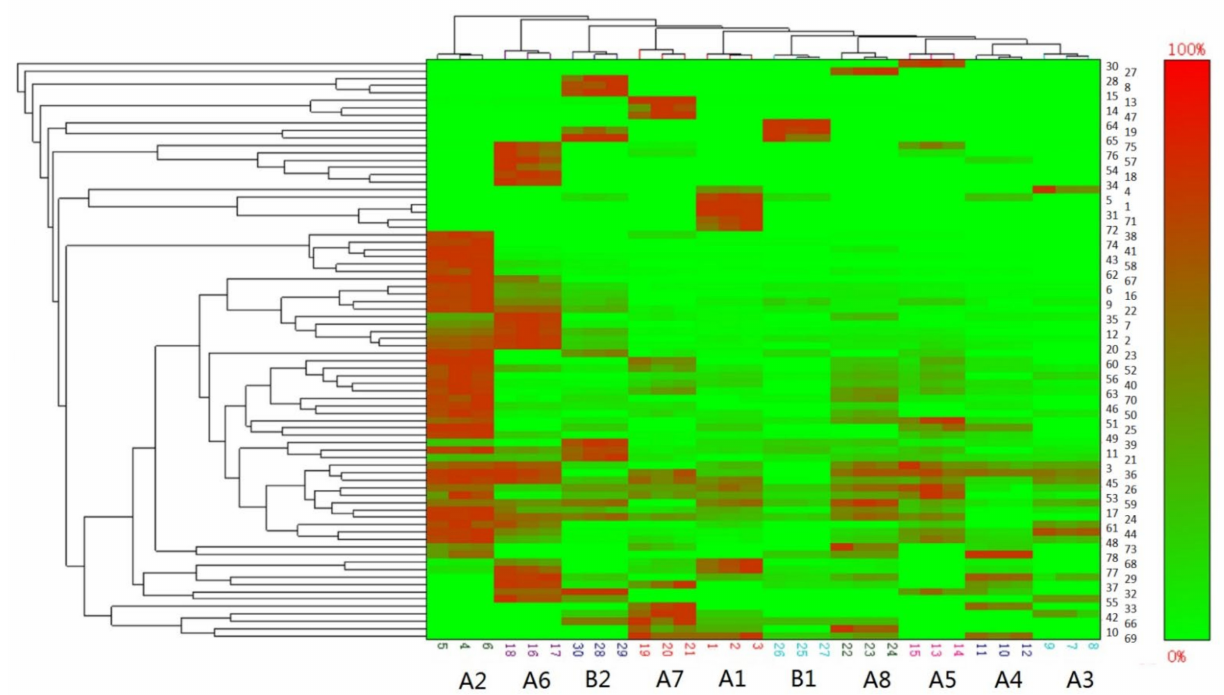
Figure 2. Cluster analysis heat map of volatile components (number on vertical axis correspond to those in Table